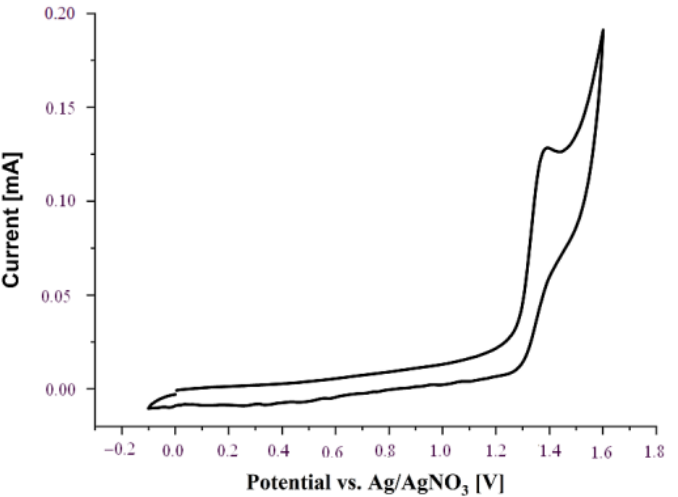
Figure 1. CV curve of crystalline 6 (0.1 mM) in MeCN at 25 ◦ C (0.1M [NBu 4 ][PF 6 ] supporting electrolyte; scan rate 100 mV s − 1 ; Pt-wire as working electrode, Ag/AgNO 3 as reference electrode.